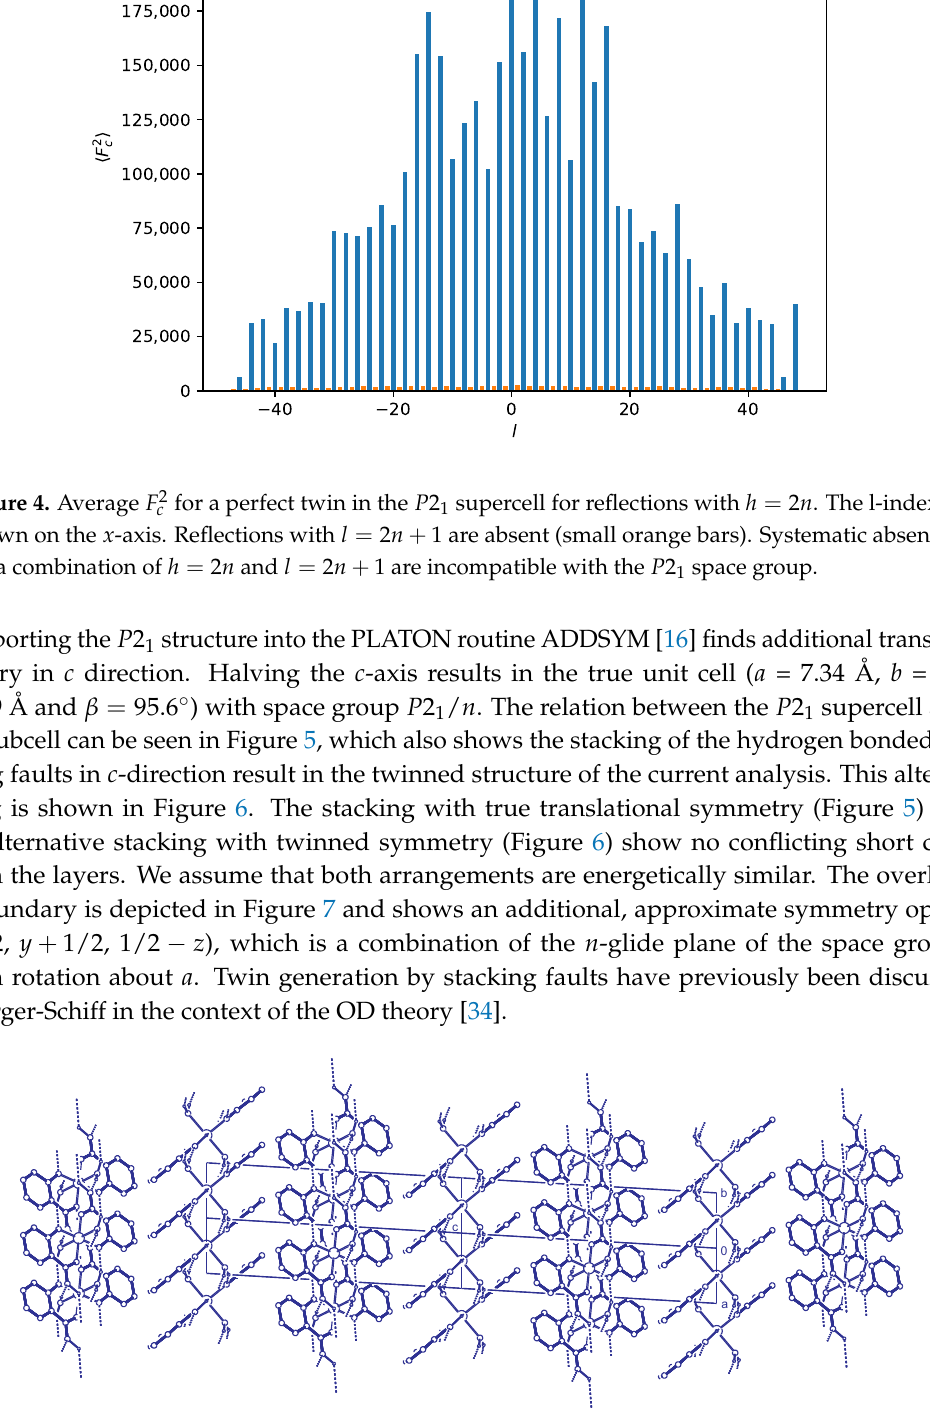
Figure 5. Stacking of the hydrogen bonded layers. Projection along the uvw = [ 110 ] direction. Two unit cells of the P 2 1 / n structure are shown. This doubled cell corresponds to the P 2 1 supercell described in the text. C-H hydrogen atoms are omitted for